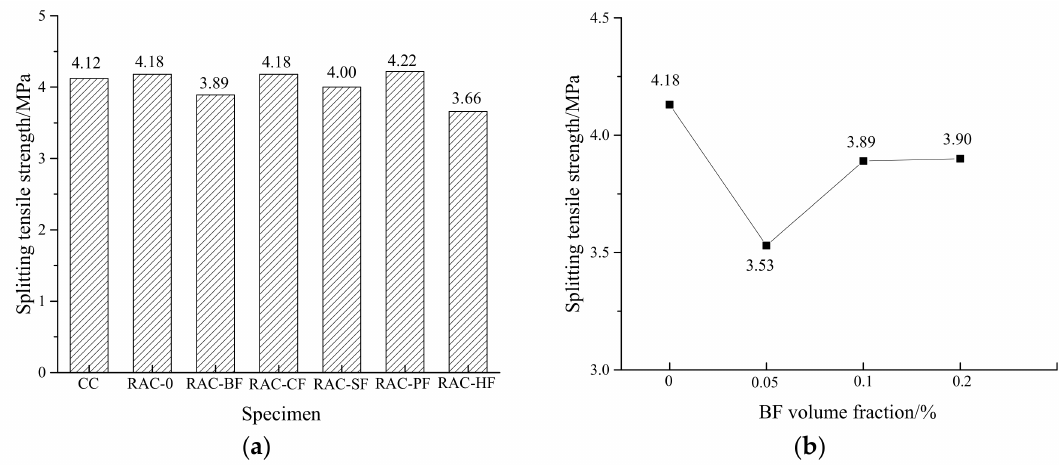
Figure 7. Changes in splitting tensile strengths of RAC. ( a ) Different fiber-reinforced RAC; ( b ) Different BF-reinforced RAC.